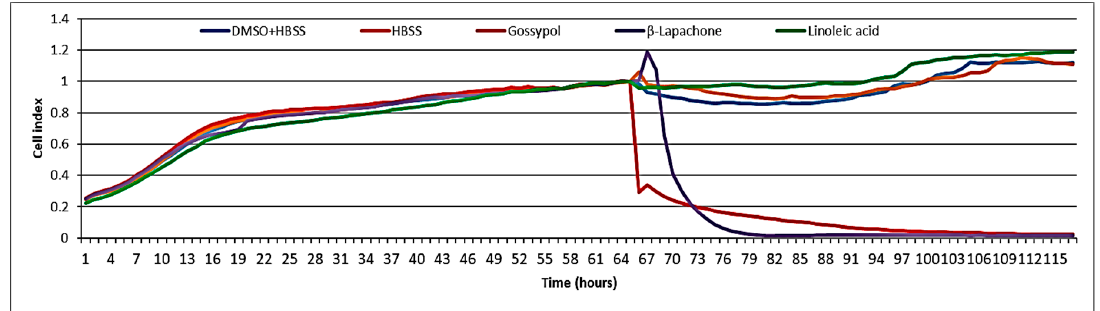
Figure 5. Cytotoxicity test of linoleic acid on BJ5ta cells.